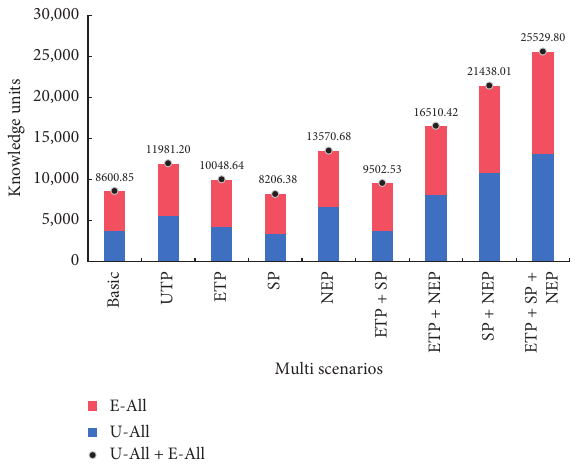
Figure 8: The trend of heterogeneous knowledge increment of EIE in